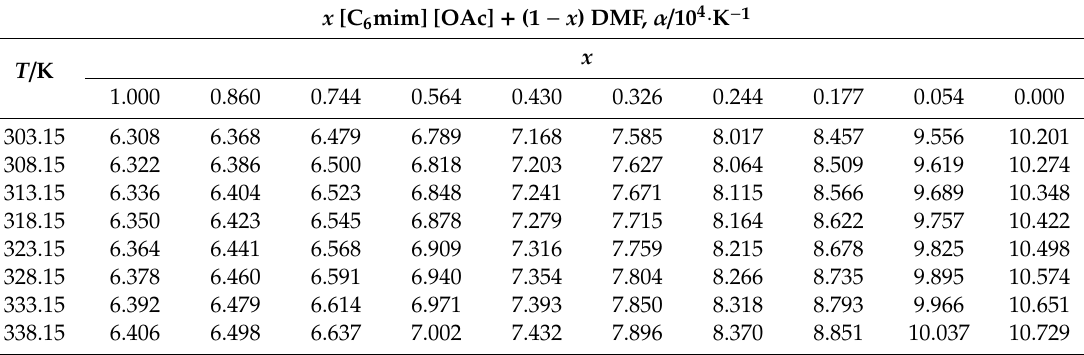
Table 7. Thermal expansion coe ffi cients of [C 6 mim] [OAc] with organic solvent of DMF.